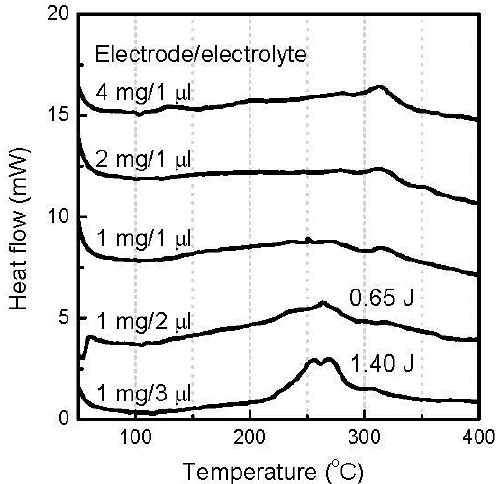
Figure 3. Differential scanning calorimeter (DSC) curves of the initial FeOF cathode with associated electrolytes in various cathode/electrolyte ratios.